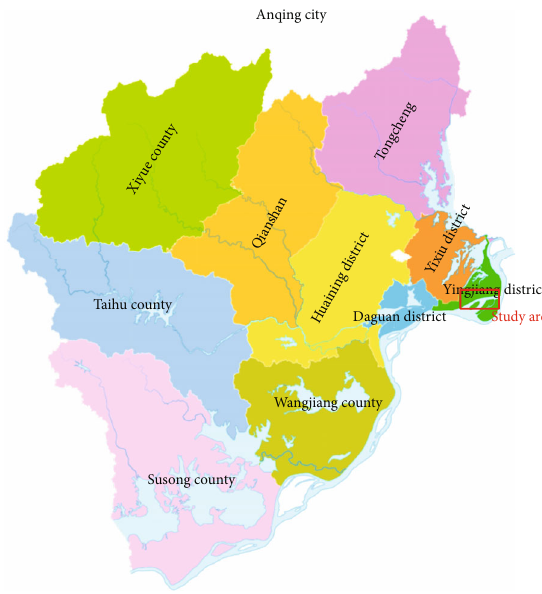
Figure 1: Geographical location and general situation of the study area.